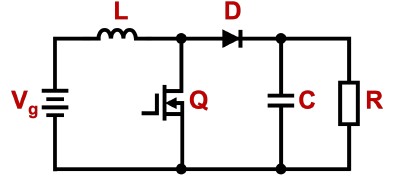
Figure 1. Boost converter model.